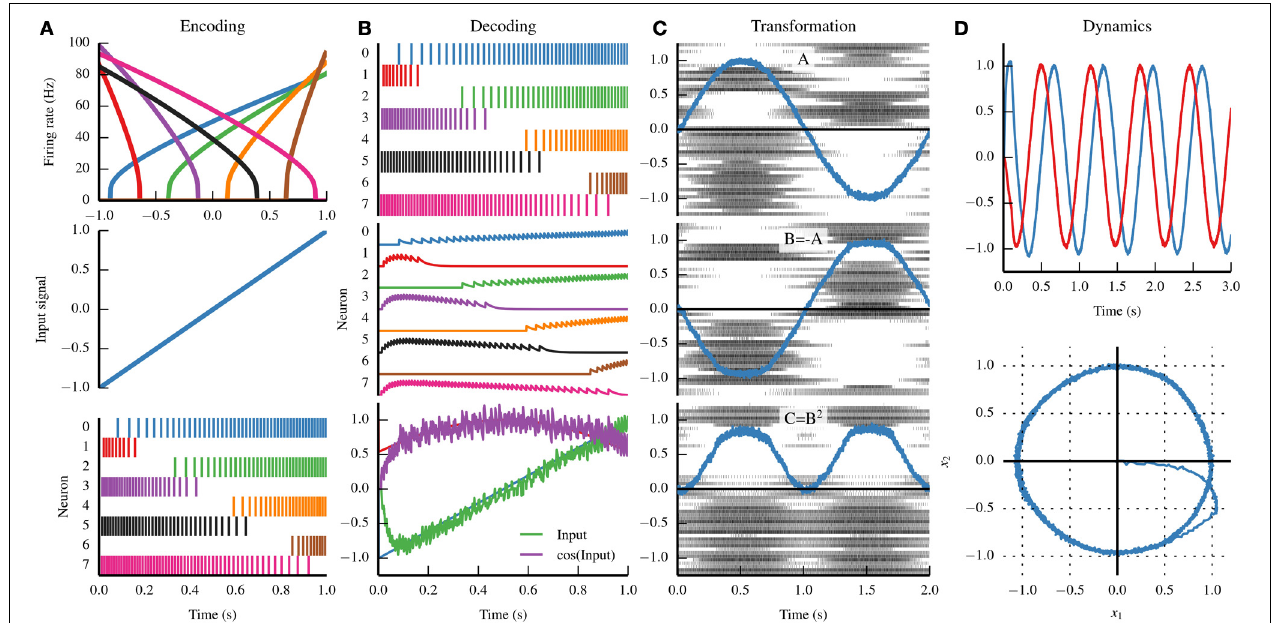
FIGURE 1 | Summary of the three principles of the Neural Engineering Framework (NEF). (A) By the representation principle, signals are encoded in neural populations based on the tuning curve of each neuron (top). The tuning curve describes how active a neuron is given some input signal. If we drive the eight neurons in the top panel with the input signal in the middle panel, we see the spike trains in the bottom panel. (B) By the representation principle, the spiking activity of a neural population can be decoded to recover the original input signal, or some transformation of that input signal. First, the firing pattern shown in the top panel is filtered with a decaying exponential filter (middle panel). The filtered activity is then summed together with a set of weights that approximates the input signal (bottom panel, green) and the cosine of the input signal (bottom panel, purple). (C) A sine wave is encoded by population A (top panel); the